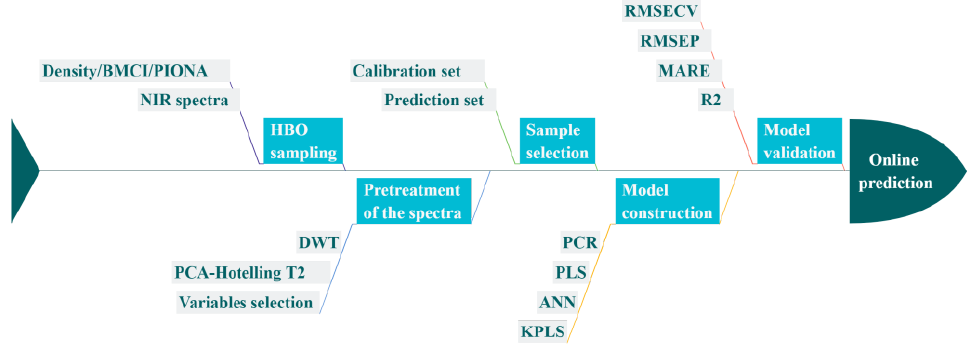
Figure 2. Flow chart of the proposed integrative approach for the rapid determination of HBO.